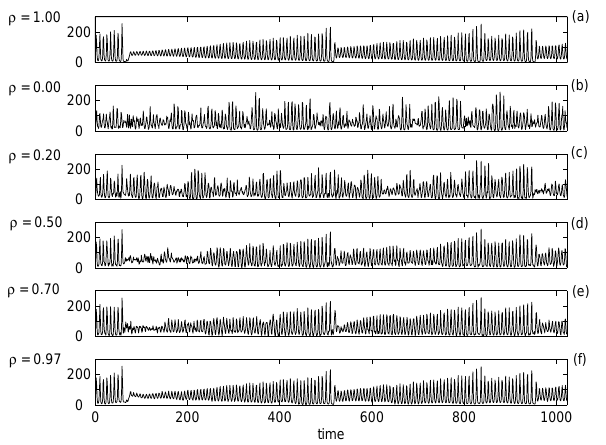
Fig. 4. Example realisations of the Santa Fe laser intensity data, x L , for various choices of ρ . Figure 4a is the original data series. The other 5 time series are those for the surrogate with the median value for A λ = 1 s at the appropriate value for ρ in Fig. 5. The values for ρ are 0.00 (3b); 0.20 (3c); 0.50 (3d); 0.70 (3e); 0.97 (3f).